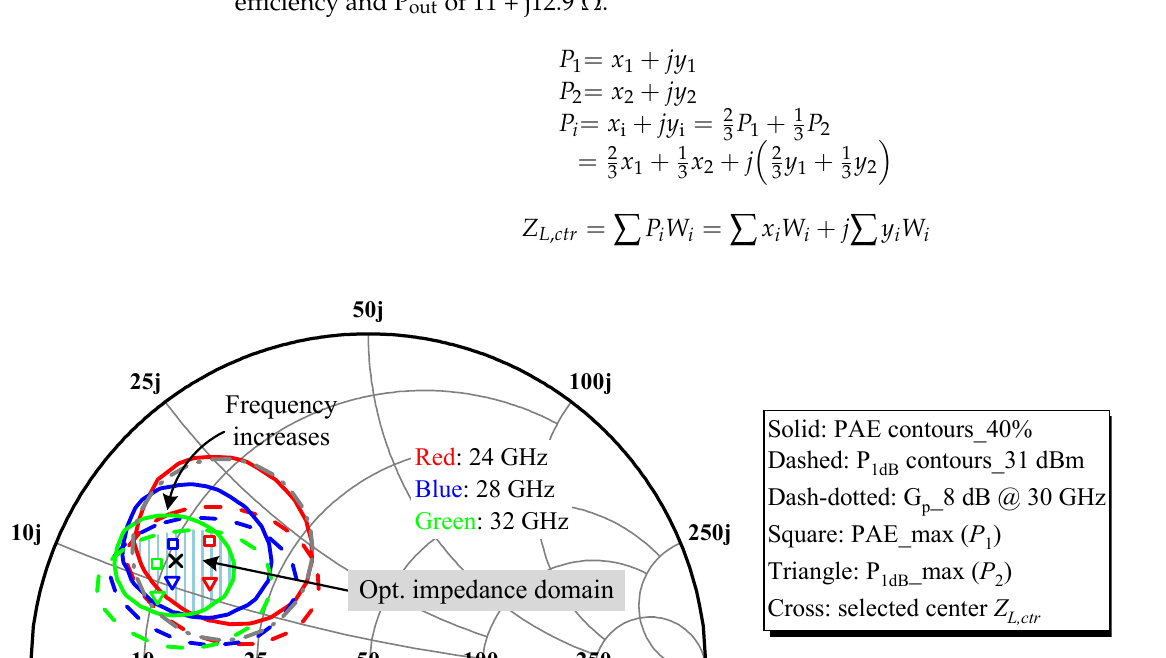
Figure 2. Simulated load-pull contours at 1 dB gain compression and the G P circle of 8 dB at 30 GHz for the output stage cell when given a nominal bias point of V D = 12 V and V G = –1 V, which yields the maximum device DC and AC transconductance [17].